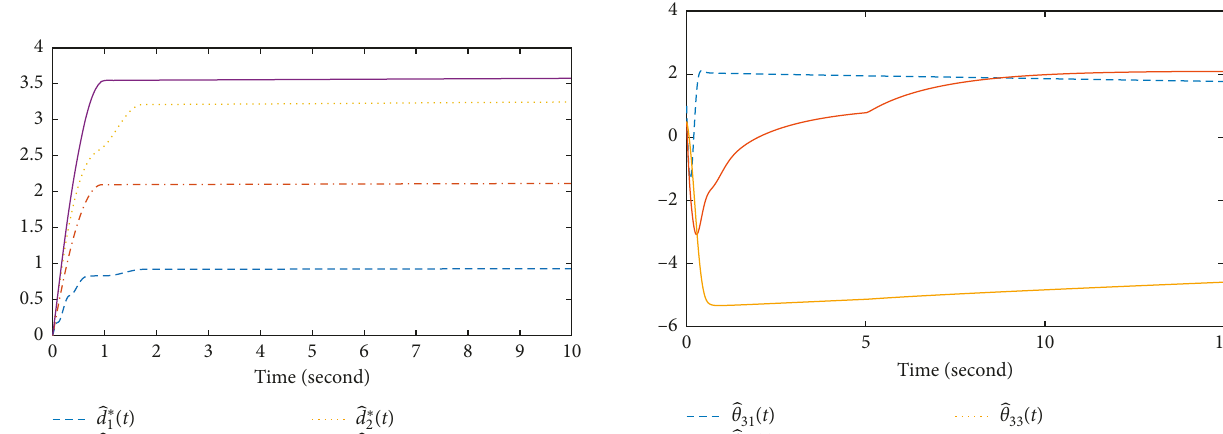
Figure 7: The estimations of d ∗